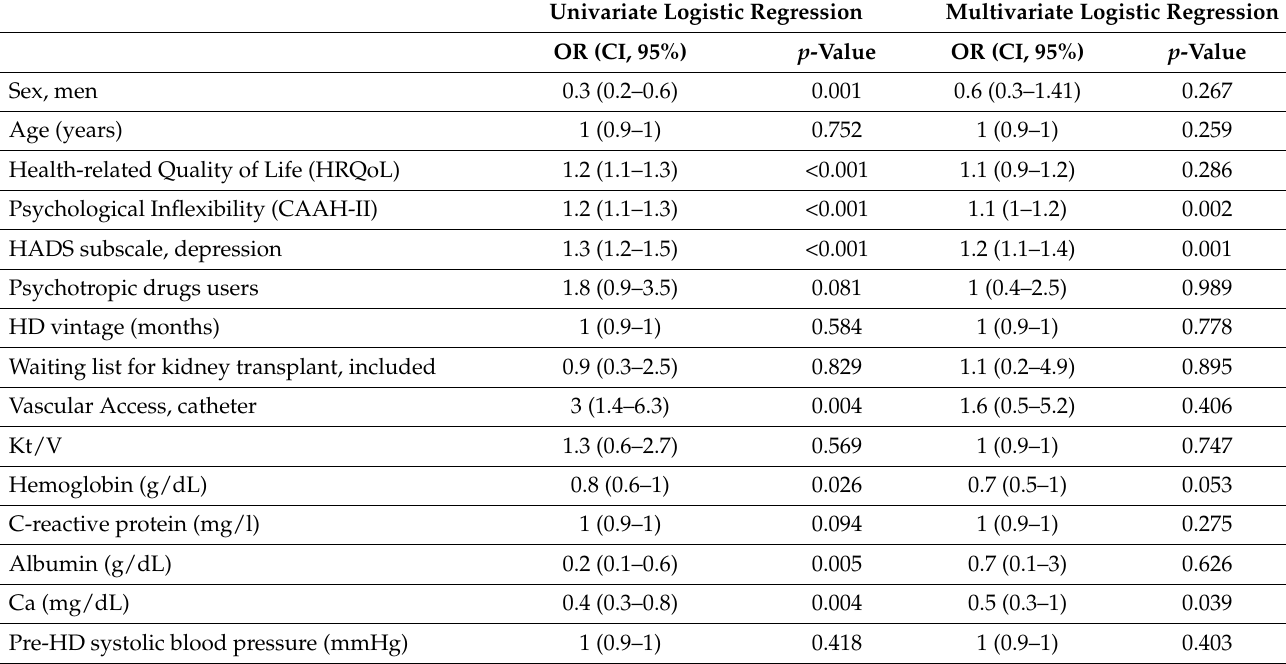
Table 4. Univariate and multivariate logistic analyses. Regression models performed to identify predictive factors for anxiety state in patients on HD treatment. Univariate Logistic